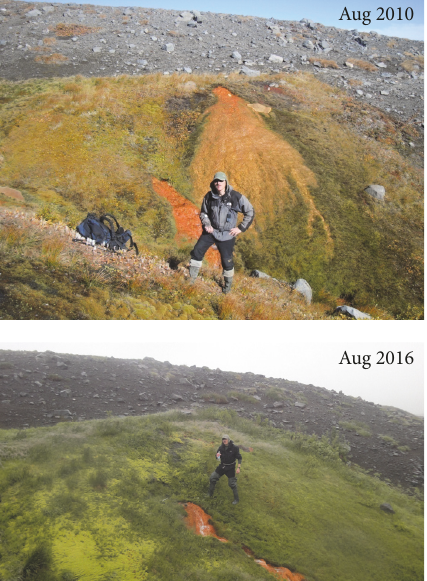
Figure 25: Koryksky Narzan-8 mineral hot spring (K8). A 4m drop of the spring discharge elevation in 6 years is clearly seen. Photo by A. V. Kiryukhin.